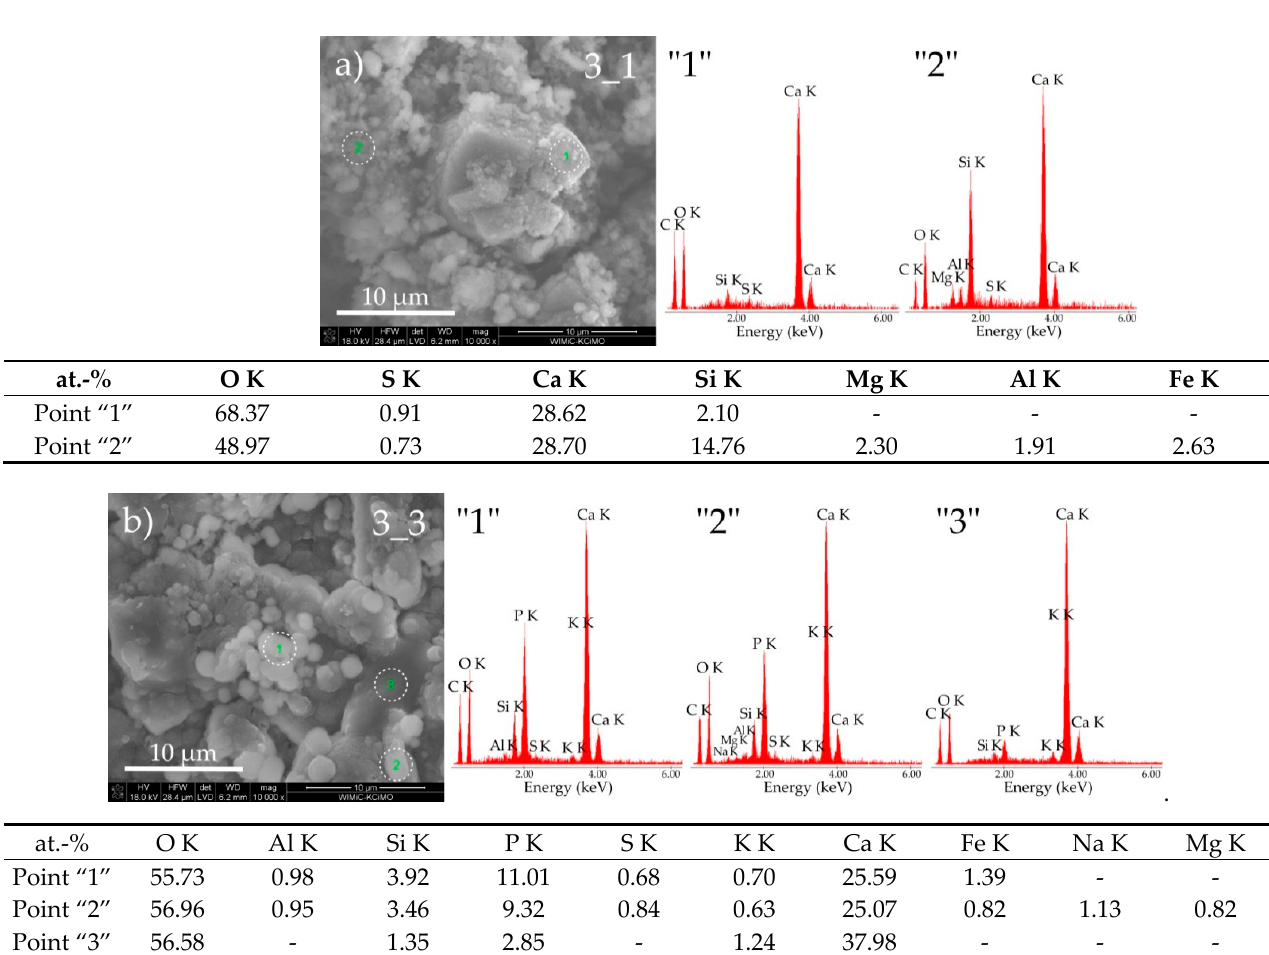
Figure 5. SEM micrographs of cement paste 3 obtained after exposure under the conditions of ( a ) water (sample 3_1) and ( b ) pig slurry (sample 3_3) with EDS quantitative point analyses from areas 1, 2, and 3.